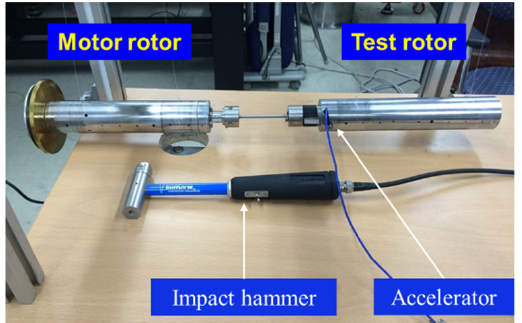
Figure 6. Overall configuration of natural mode characteristic test environment.